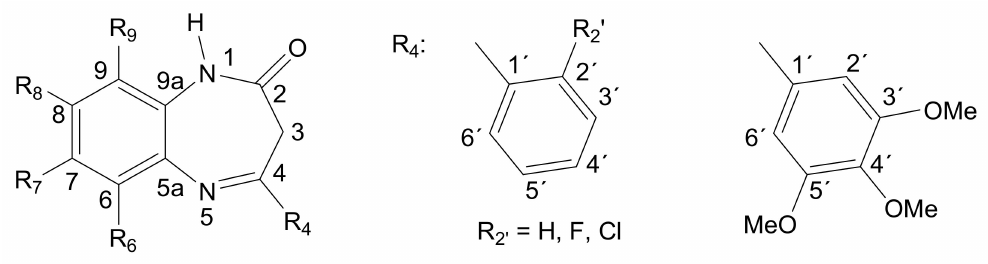
Figure 3. Atom numbering used for the NMR